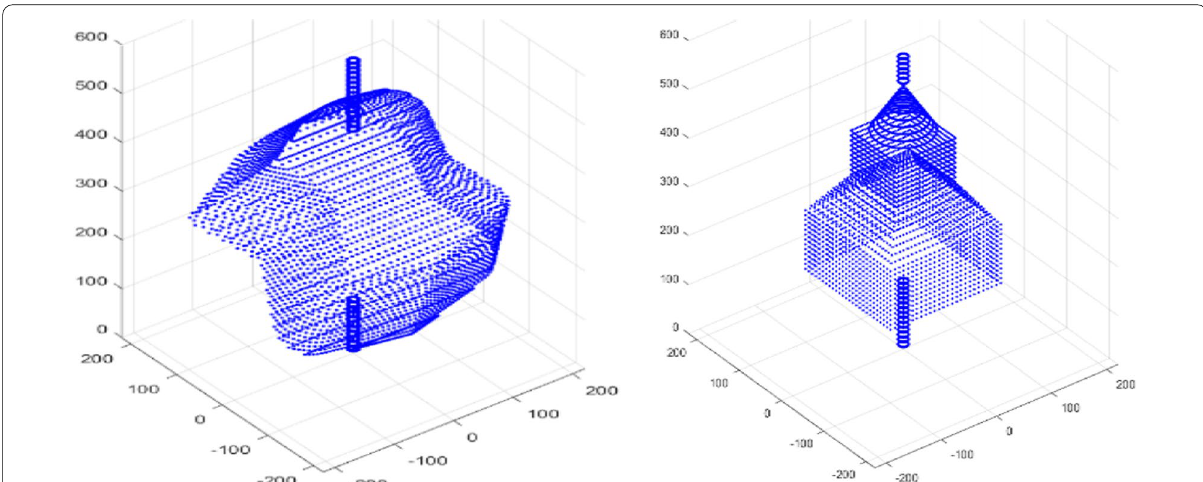
Fig. 1 Examples with the guided column after the slicing process in the form of points. The output PTS file contained the intersection points of the CAD model contours and the coordinates of the intersection points that represented the guided